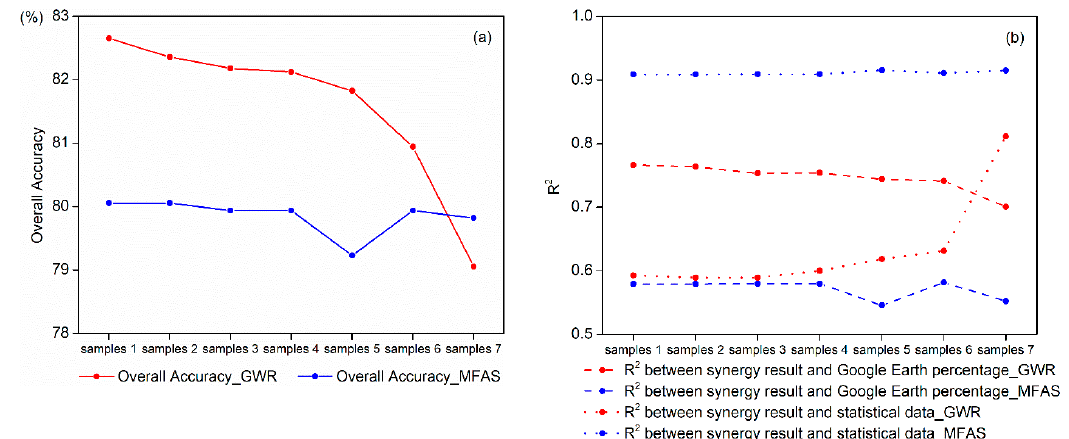
Figure 4. Performance assessment and comparisons including spatial accuracy ( a ), consistency with cropland percentages, and consistency with cropland area from the statistics using various sample sets ( b ).